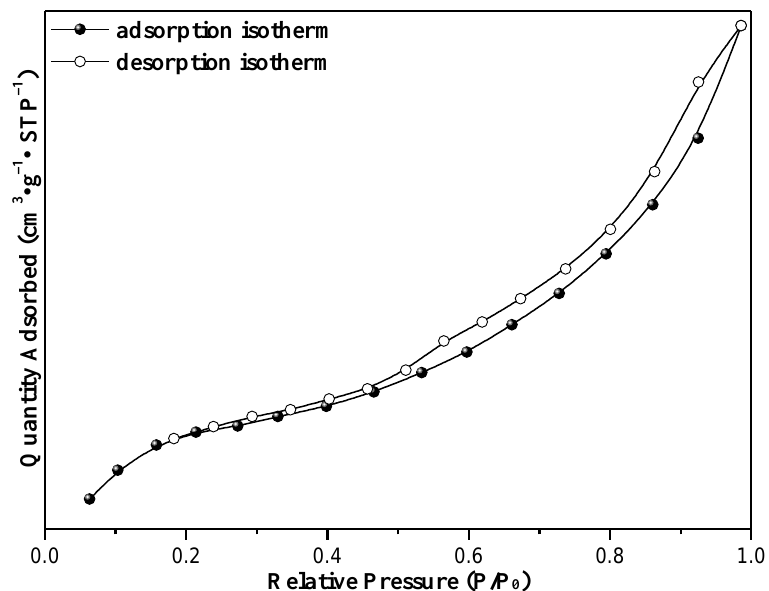
Figure 4. N 2 adsorption-desorption isotherms of the Co-ZIF catalyst.